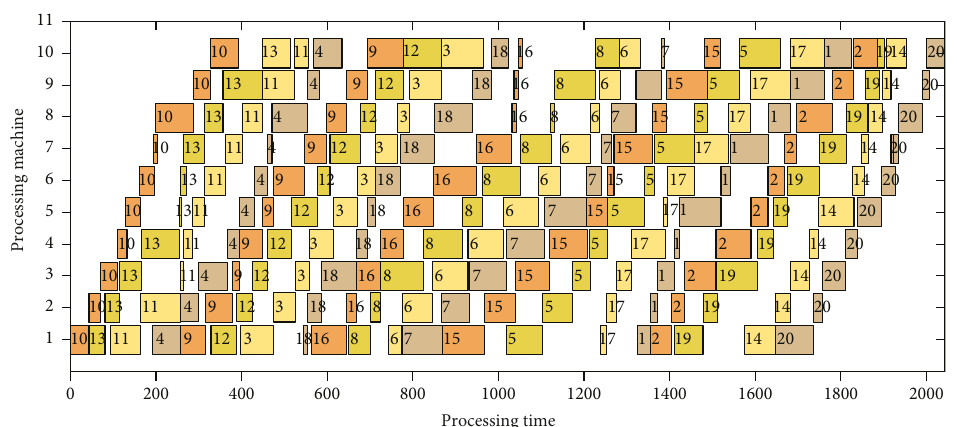
Figure 12: Gantt chart of the solution for Rec07.